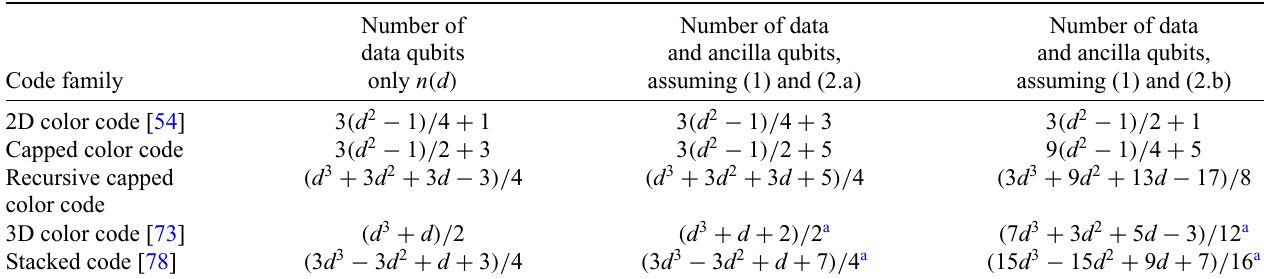
TABLE IV. Comparison between the numbers of required qubits for a 2D color code, a capped color code (in H form), a recursive capped color code, a traditional 3D color code, and a stacked code of distance d . The assumptions being used in the third and the fourth columns are that (1) qubit preparation and qubit measurement are fast, and that (2.a) all-to-all connectivity between data and ancilla qubits are allowed or (2.b) there are dedicated syndrome and flag ancillas for each generator measurement. Number of Number of data Number of data data qubits and ancilla qubits, and ancilla qubits, Code family only n ( d ) assuming (1) and (2.a) assuming (1) and (2.b) Capped color